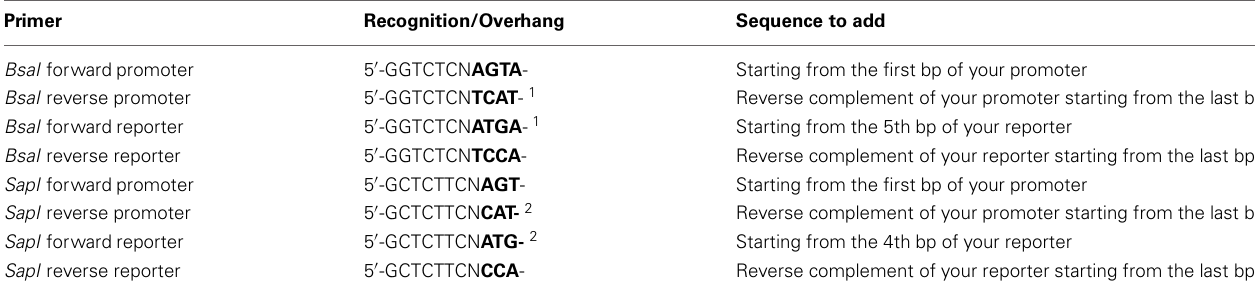
Table 4 | Sequences to add BsaI or SapI sites to the PCR products prior to Golden Gate Cloning for a two-part (promoter plus reporter) scar-less assembly into the destination